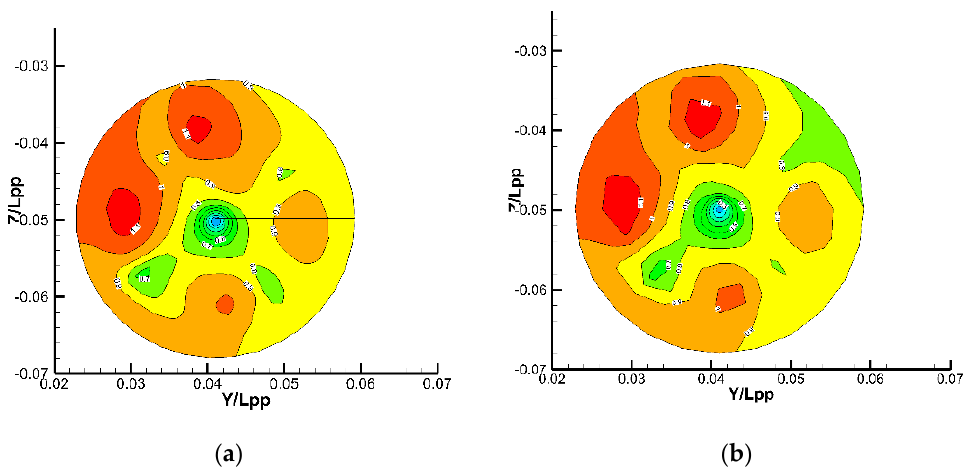
Figure 7. Axial flow field of full scale and model scale at X / L pp = 0.115: ( a ) Full scale: Fn = 0.182, n = 1.555 rps; ( b ) Model scale: Fn = 0.182, n = 6.707 rps.